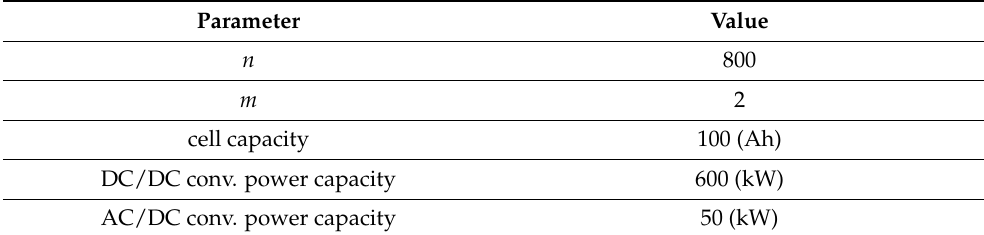
Table 6. The assumed parameters of single supplying